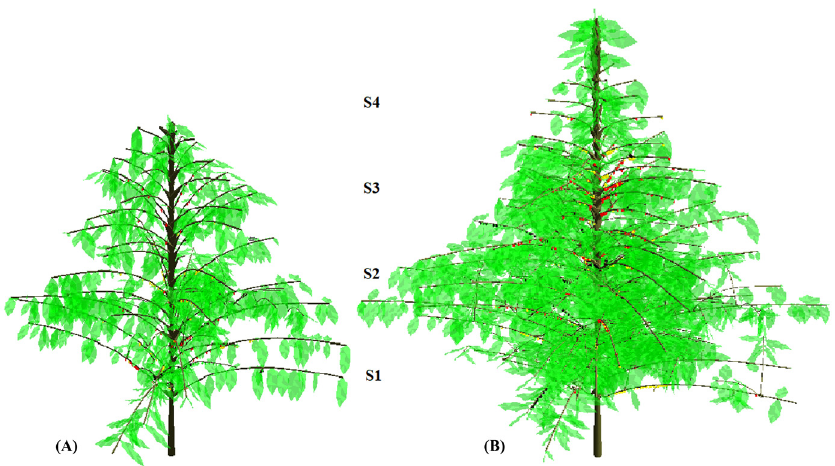
Figure 1. Snapshots of 3D reconstruction of one ‘E083 ′ irrigated plant in the ( A ) 1st (2012) and ( B ) 2nd (2013) harvest year, illustrating the strata along plant canopy: S1: 20–60 cm (or < 60 cm); S2: 61–100 cm; S3: 101–140 cm; S4 >140 cm.